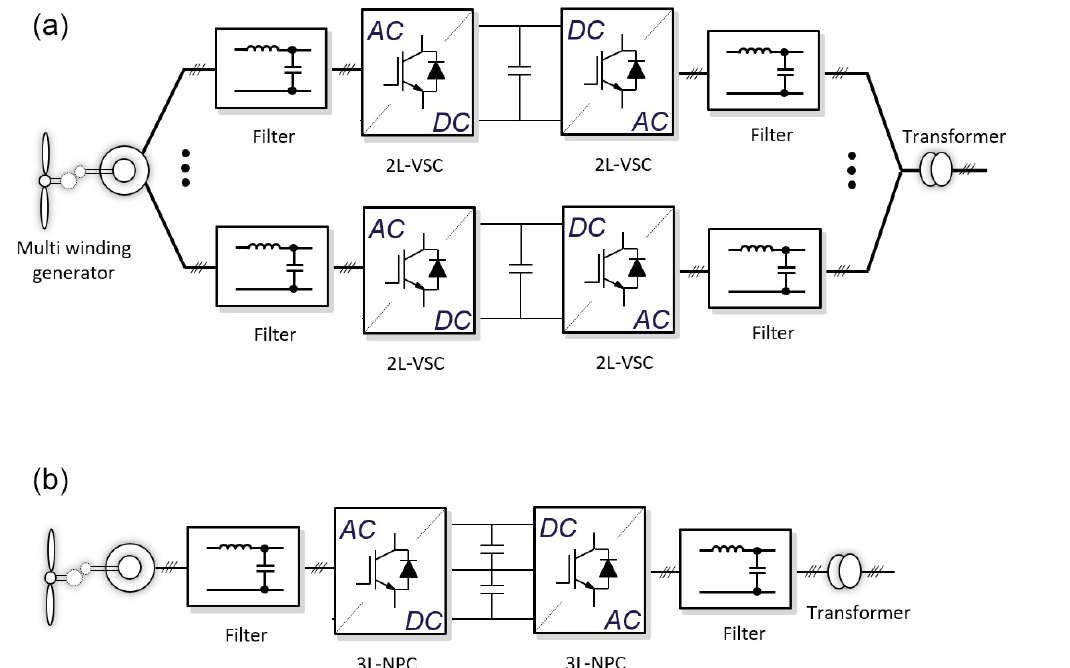
Figure 4. Beyond 10MW wind power converter topologies. (a) Two-level BTB VSC in parallel. (b) Three-level NPC converter (illustration by Zian